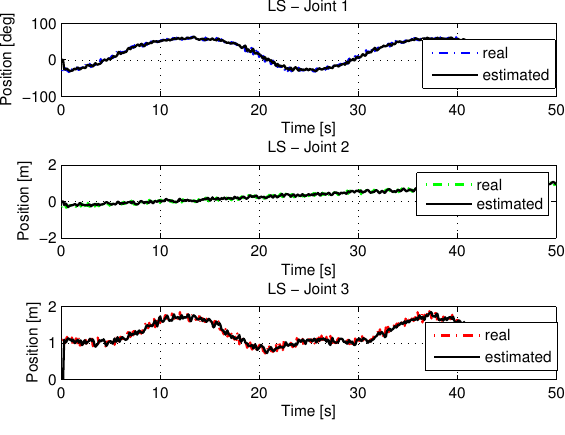
Figure 22. Trajectory in the joint space identified with LS with noise.